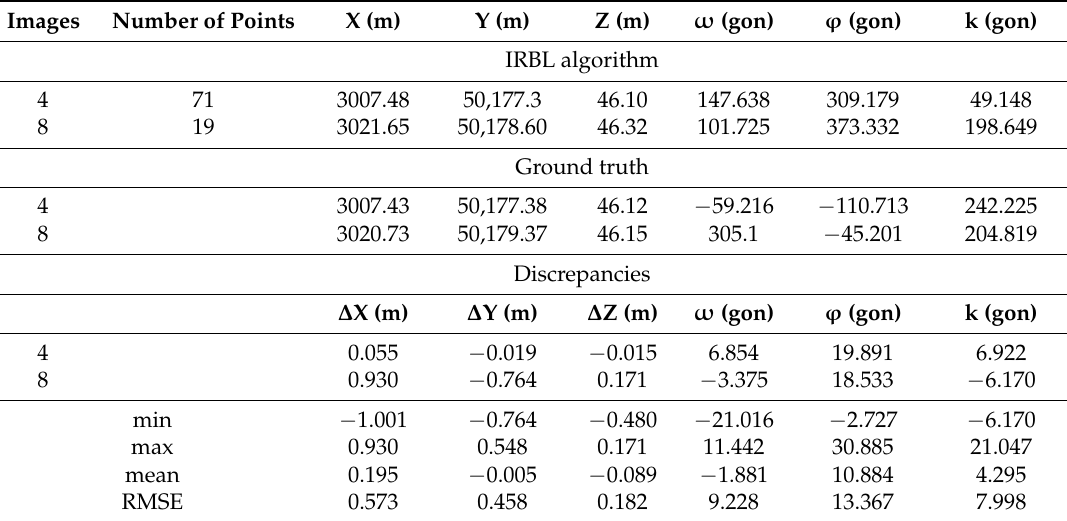
Table 4. Accuracy in Bangbae station with Samsung